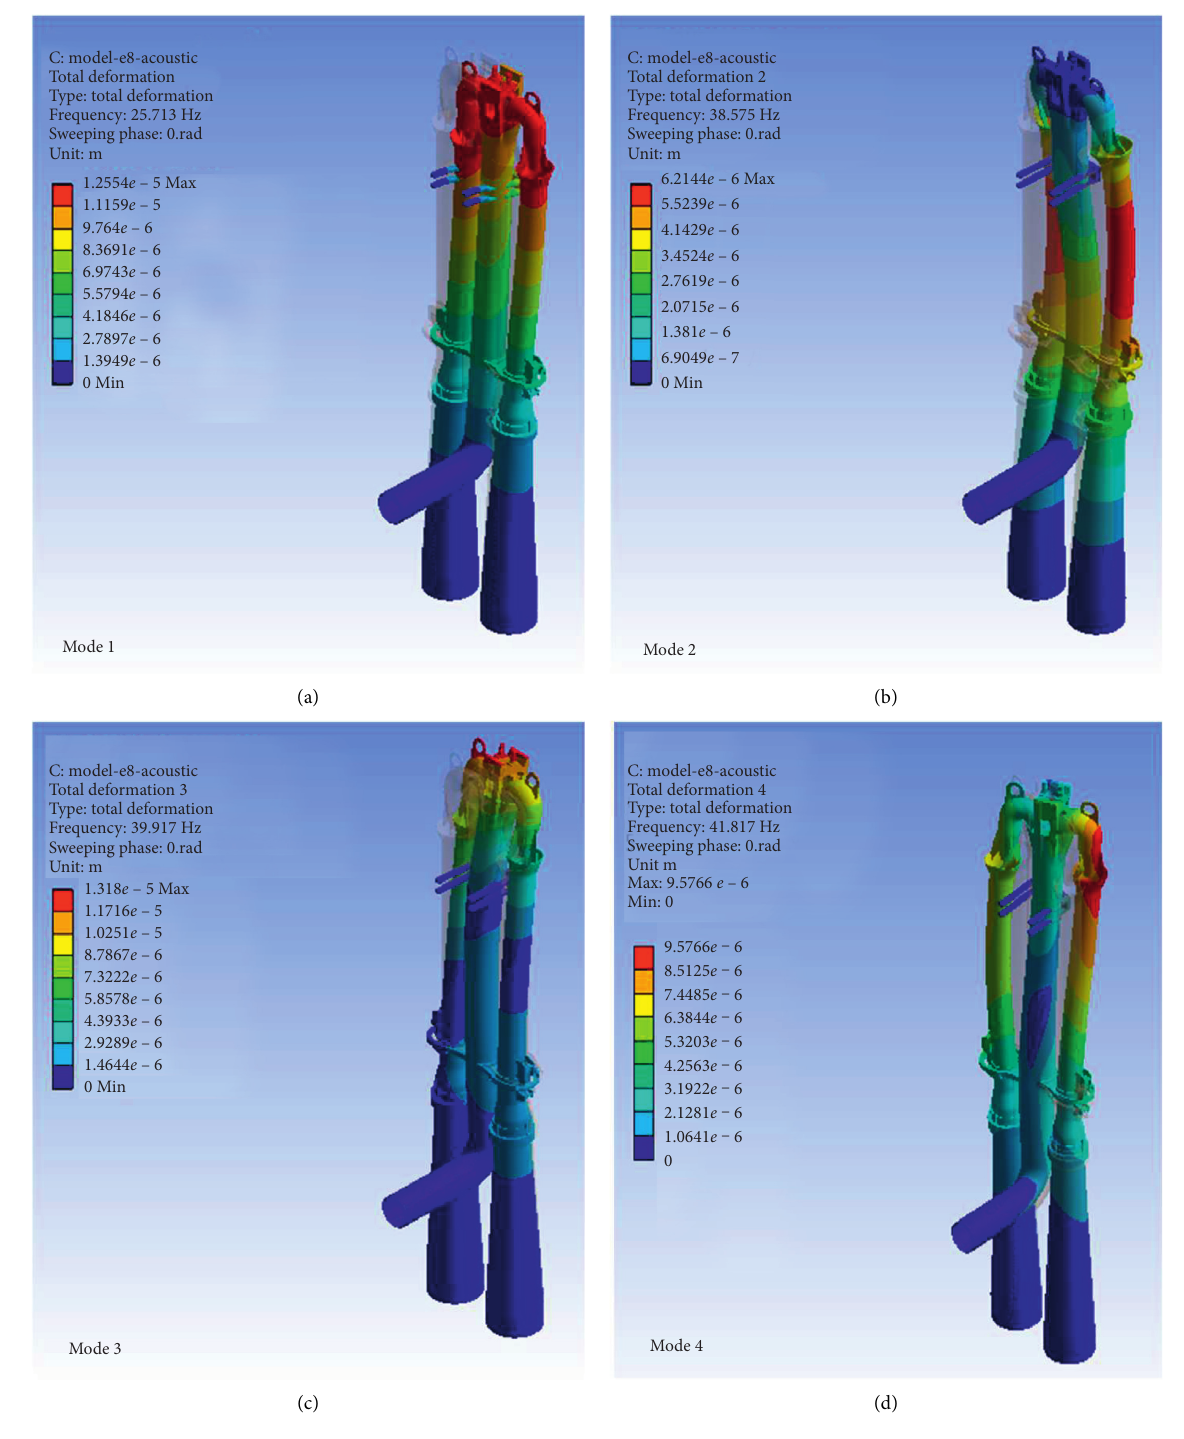
Figure 5: First four modes of vibration of a jet pump assembly. Table 2: Natural frequencies of the jet pump